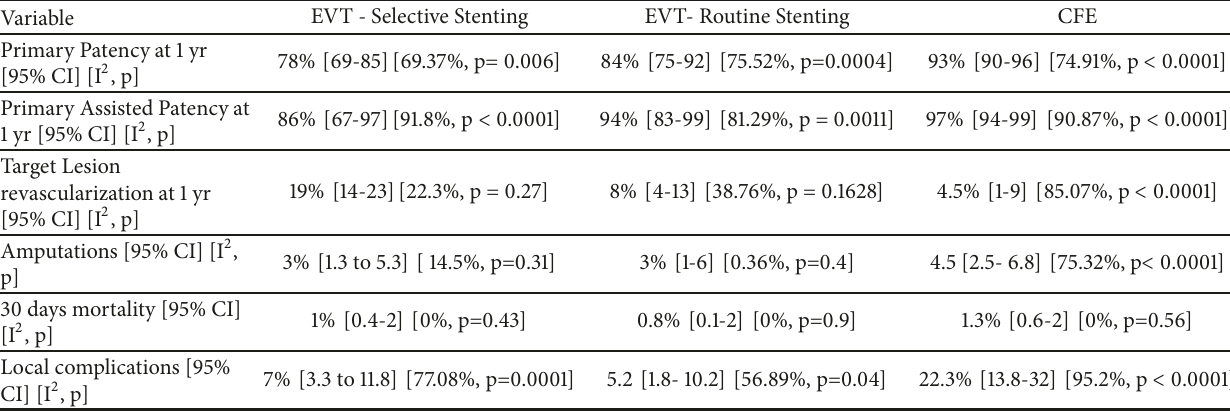
Table 4: Clinical efficacy as demonstrated by pooled analysis of identified outcomes between the different treatment strategies.